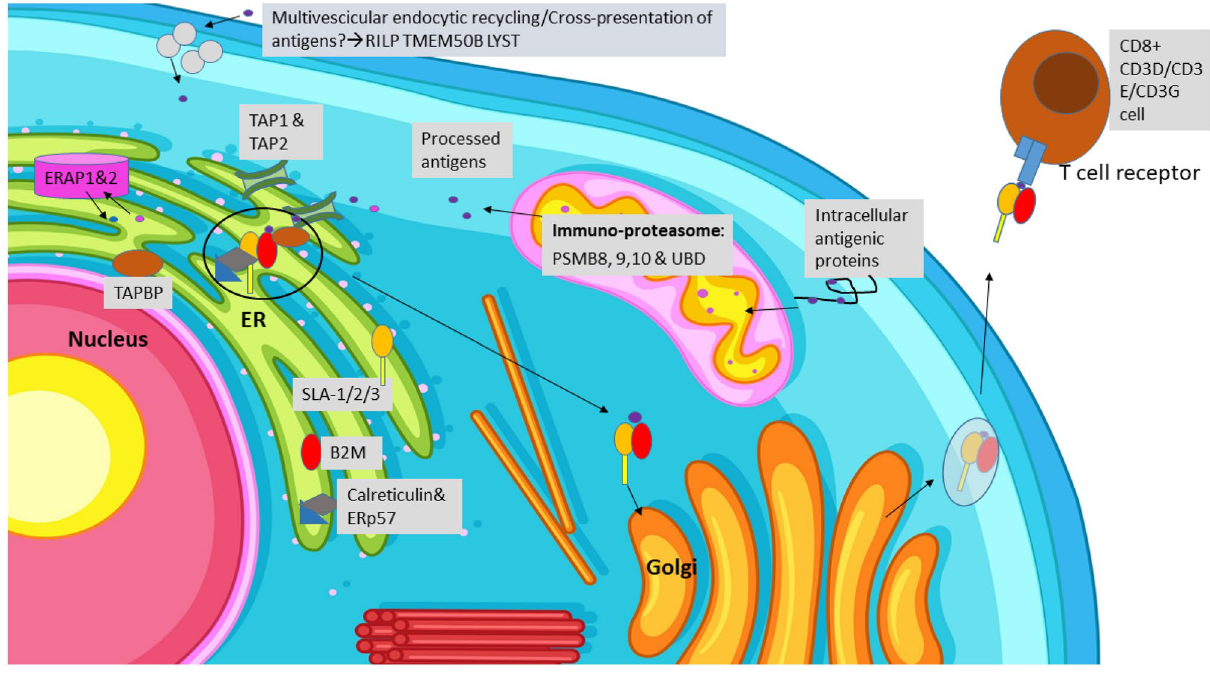
Figure 7. Scheme of the process related to MHC I activation upregulated in post-weaning pigs. Upregulated genes, alone or inside enriched groups, are in the figure in capital letters. In activated cells, such as DCs, a special proteasome complex is formed, thanks to 20S Subunit Beta 8, 9 and 10 (PSMB8/9/10) and ubiquitin D (UBD), to process intracellular antigenic proteins. Cross-presentation of external antigens (from neighbouring cells, cell fragments) can be processed using multivescicular body sorting ( RILP Rab Interacting Lysosomal Protein, TMEM50B Transmembrane Protein 50B, LYST lysosomal Trafficking Regulator). Entering into the endoplasmic reticulum (ER) by the channel made by Transporter 1 and Transporter 2, ATP Binding Cassette Subfamily B Members (TAP1 and TAP2), accepted antigens are integrated to MHC I (SLA-1, SLA-2, SLA-3) inside the complex, also formed by the TAP Binding Protein (TAPBP), β-2-microglobulin (B2M) calreticulin and ERp57. Some peptides must be preliminarily trimmed by endoplasmic reticulum aminopeptidase 1 and 2 (ERAP1 and ERAP2). The antigen-charged complex B2M—MHC I is then exported to the Golgi apparatus where it is packed in vesicle form to be exported from the cell. Design created in Microsoft PowerPoint 2016, and a part of the personal design freely obtained from http:// www. freep ik.